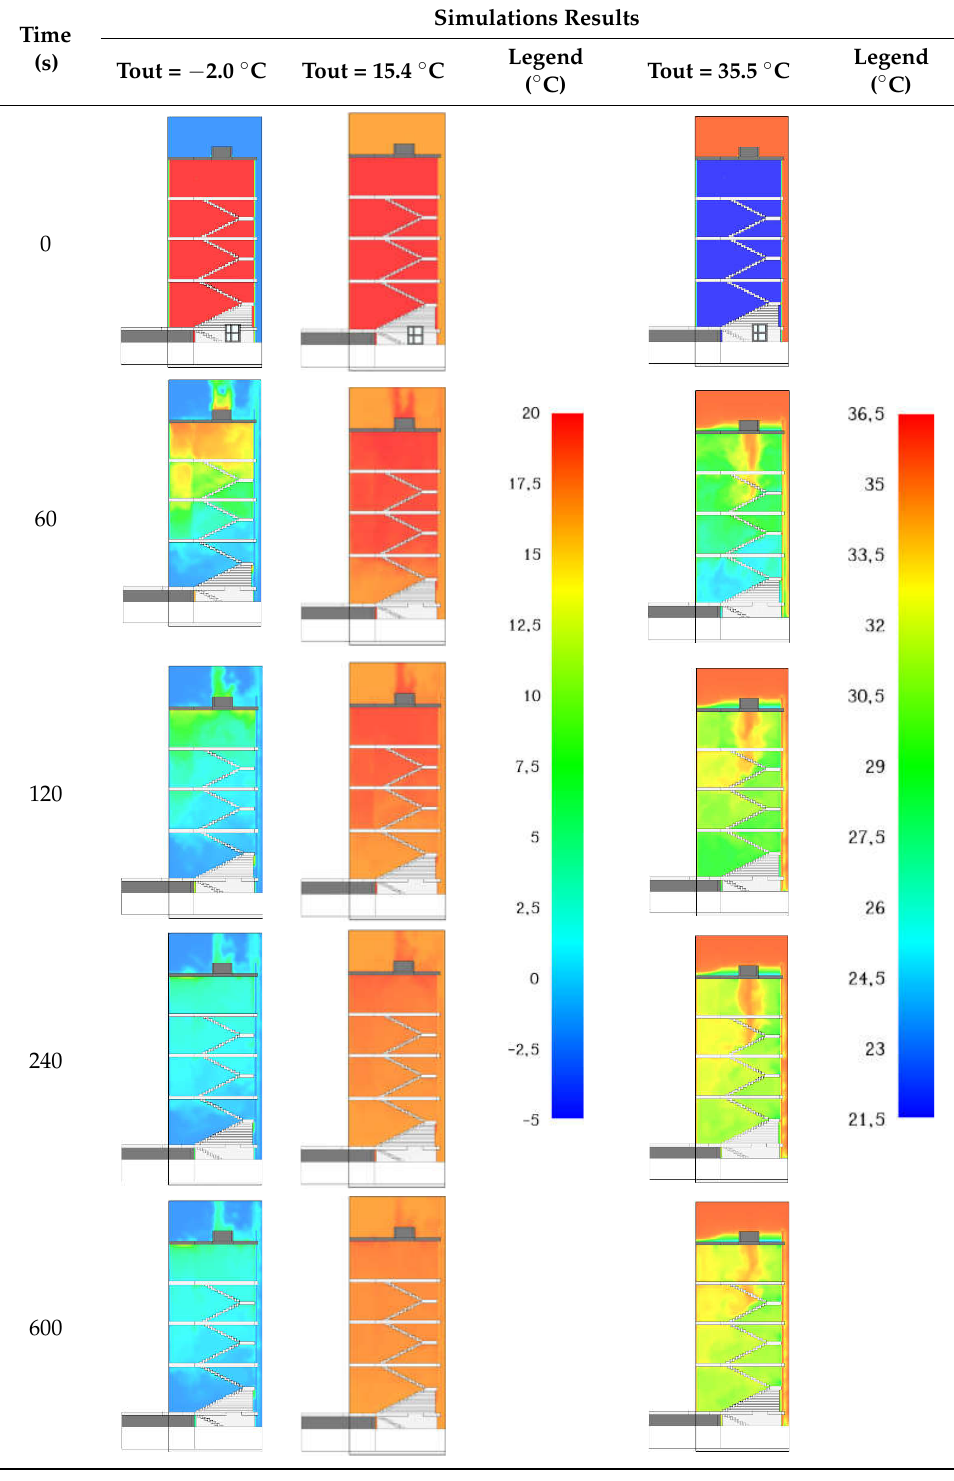
Table 2. Variation in air temperature in the staircase space depending on the outside temperature.